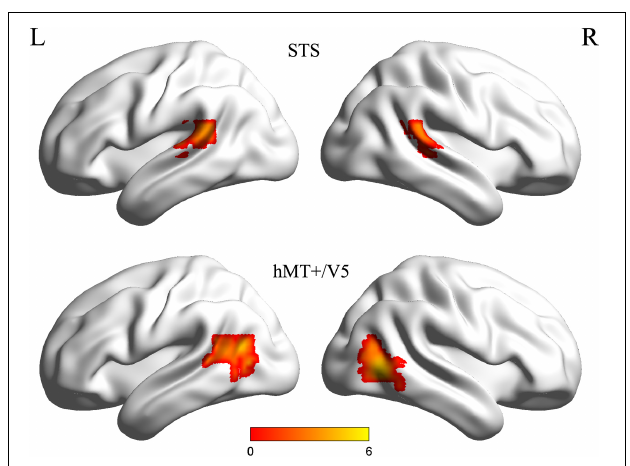
FIGURE 2 | Statistical maps of the significant clusters of superior temporal sulcus (STS) and hMT + /V5 of a representative subject (uncorrected p < 0.05 with a cluster size > 20 voxels). Individual subjects’ motion-sensitive regions of interest (ROIs) were defined as 9 mm spheres surrounding the peak